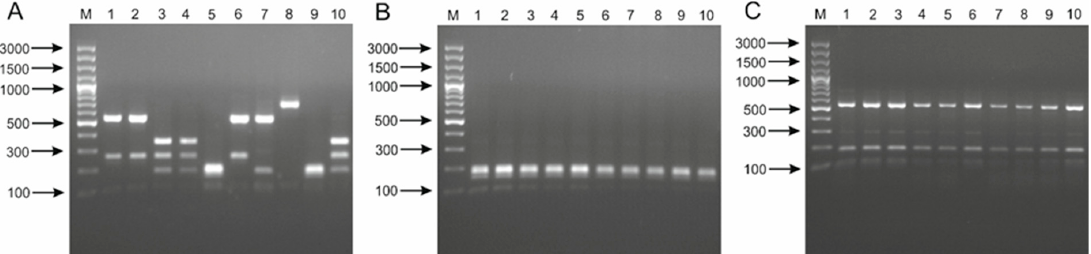
Figure 1. Restriction fragment length polymorphism (RFLP) patterns generated from restriction analysis of tuf amplicon (~800 bp) of 30 strains belong to L. casei group using HaeIII restrictase. Analysis of the discriminatory power of the procedure applied was performed for 10 strains of L. casei ( A )—M, DNA molecular marker; 1, LMG 6904; 2, LMG 23516; 3, LMG 24099; 4, LMG 24102; 5, JCM 2120; 6,